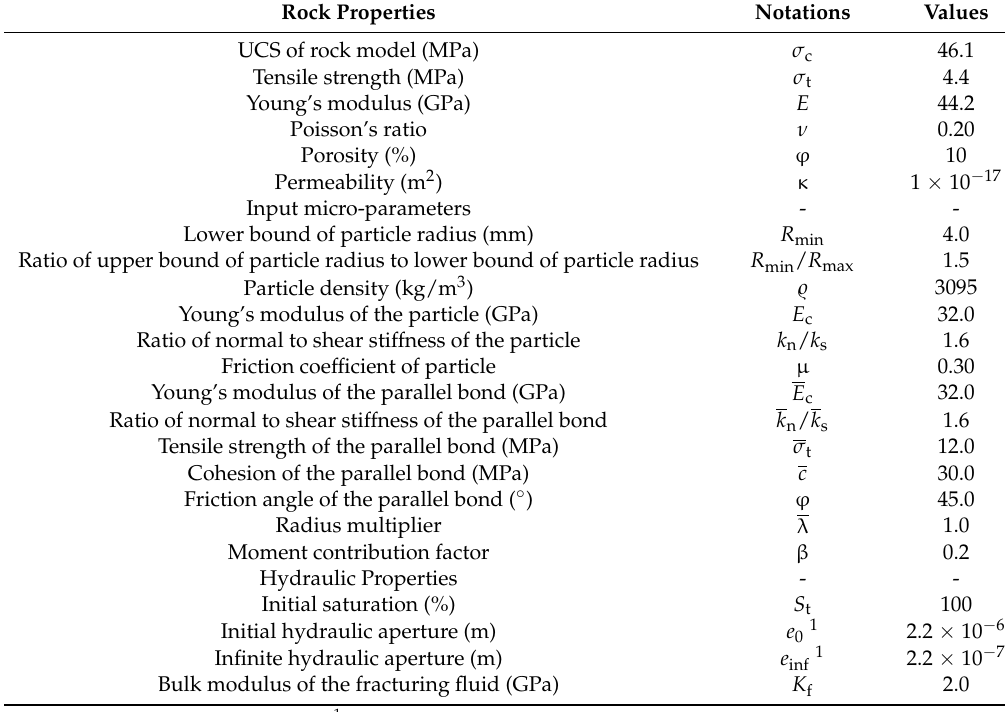
Ratio of upper bound of particle radius to lower bound of particle